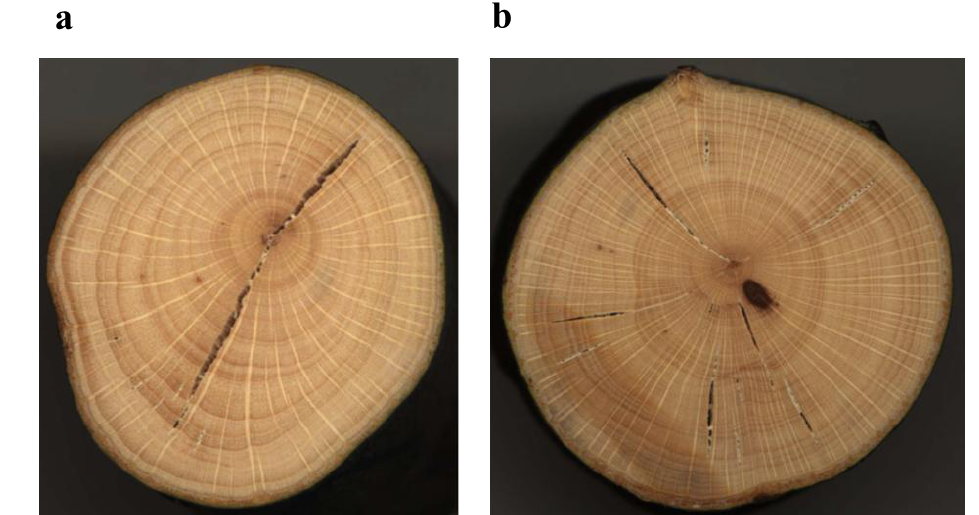
Figure 12. Stem discs for tree ring analysis, ( a ) 31-year-old beech plant with a root collar diameter of 33 mm from a less dry plot, ( b ) 42-year-old beech plant with a root collar diameter of 41 mm from a dry